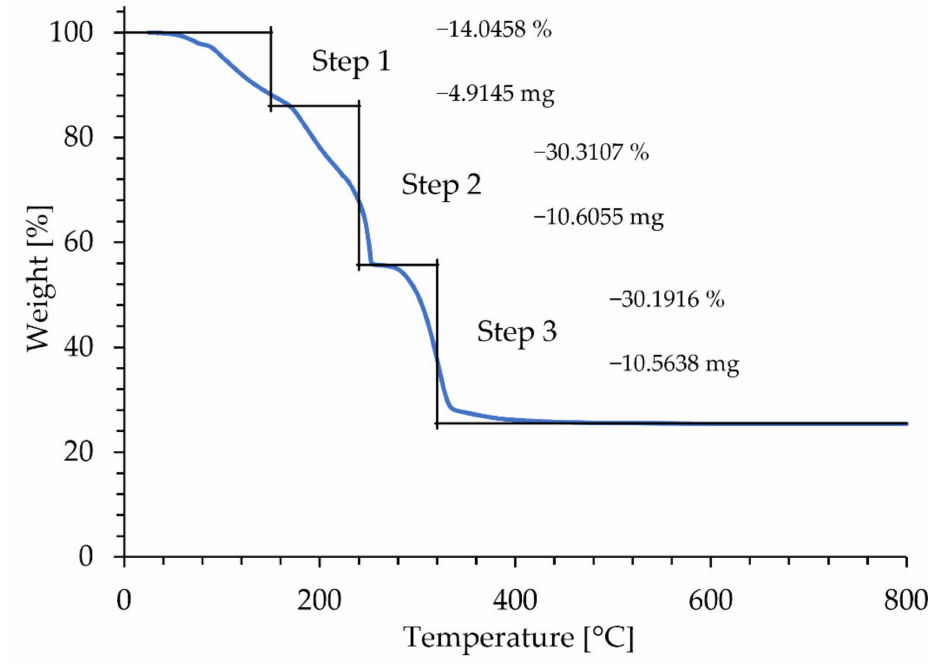
Figure 4. TGA plot of the thermal decomposition of Ni(NO 3 ) 2 × 6 H 2 O.